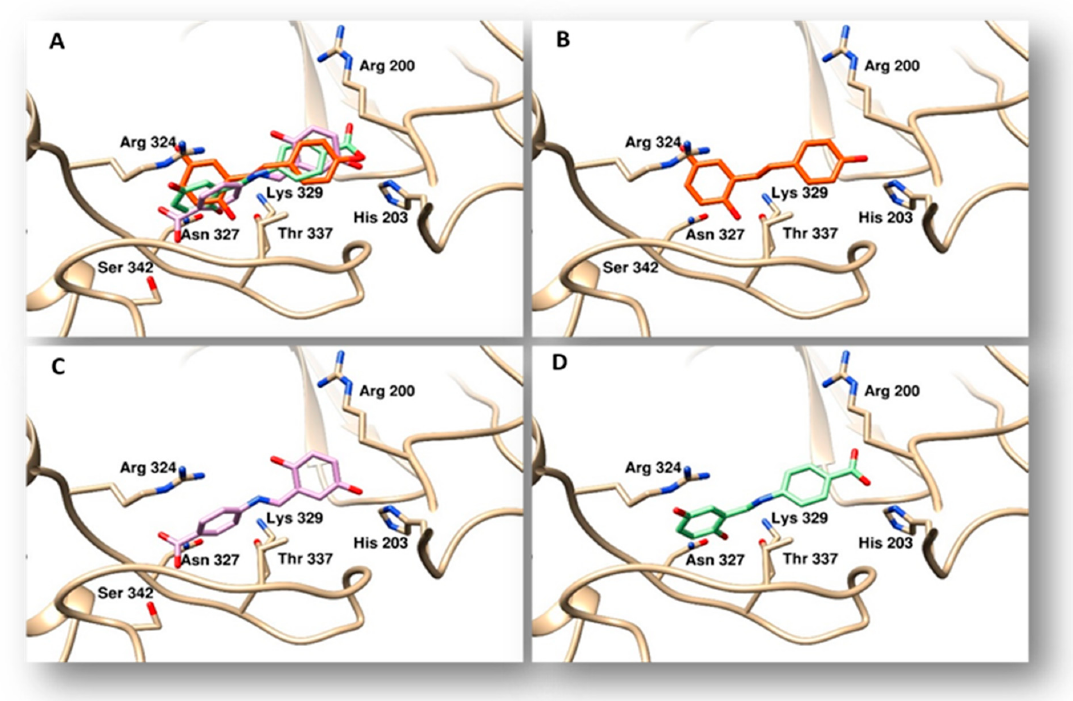
Figure 4. Binding modes of compounds evaluated to topoisomerase I. The protein is represented as tan ribbons, amino acids involved in the binding are evidenced as sticks and properly labelled. Panel ( A ), superposition of resveratrol, compounds 3 and 4 . Panel ( B ), the binding mode of resveratrol is indicated by orange sticks. Panel ( C ), binding mode of compound 3 drawn in violet sticks. Panel ( D ), compound 4 is reported as light green sticks in its binding pose.